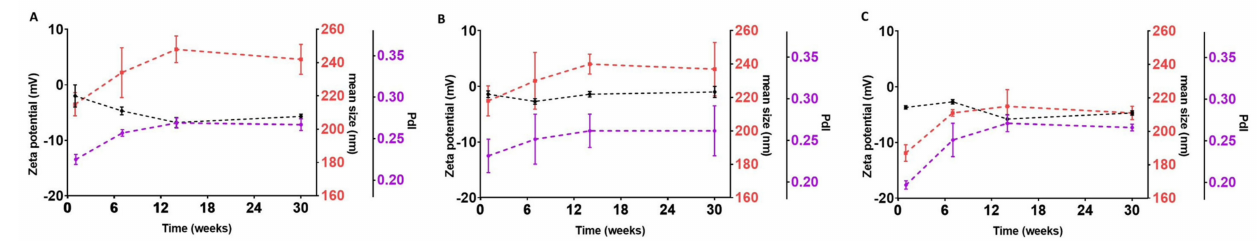
Figure 2. Stability of the SLNs (composed by the solid lipid Compritol ® HD5 ATO 345 and the emulsifier Pluronic-F127) loaded with ( A ) EGCG, ( B ) resveratrol or ( C ) myricetin. Black line: Graph- ical representation of variations in ZP values (data plotted on the left Y-axis); Red line: Graphical representation of variations in mean sizes (data plotted on the first right Y-axis); Purple line: Graphical representation of variations in PdI values (data plotted on the second right Y-axis). Results are given as mean ± SD ( n =